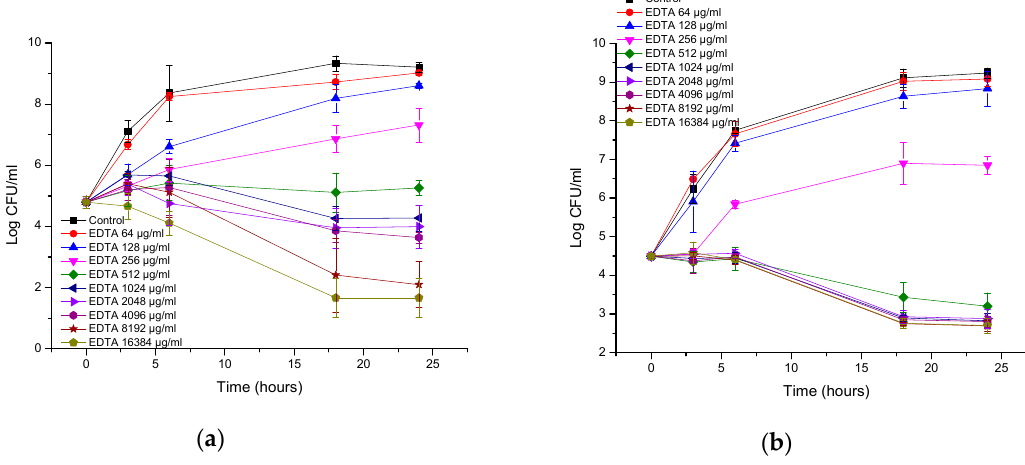
Figure 5. Time-kill curves of EDTA against ( a ) Acinetobacter baumannii ATCC (American Type Culture Collection); ( b ) Acinetobacter baumannii RCH.